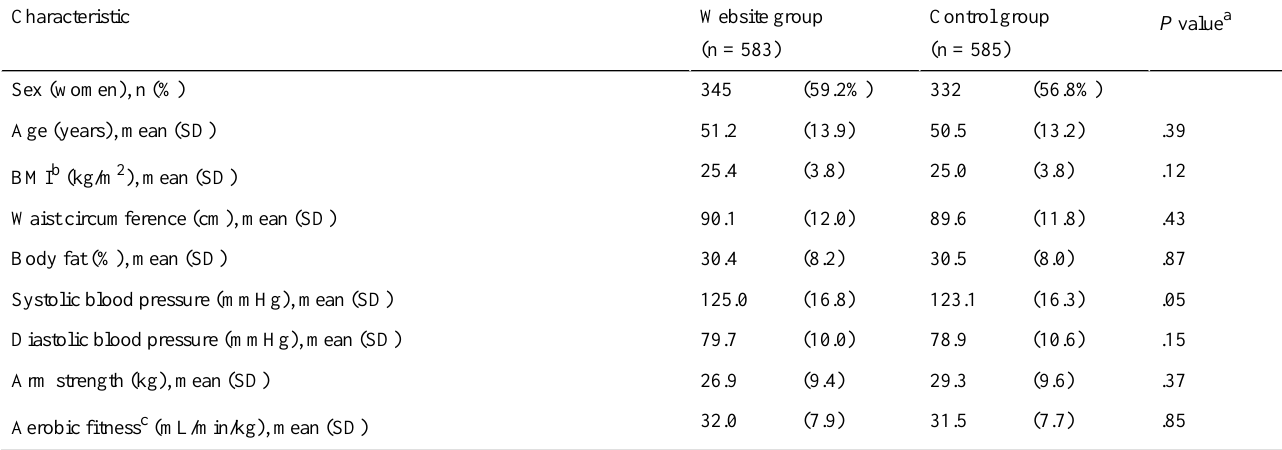
Table 3. Baseline characteristics of the subsample of participants in the health examination by website and control group (Denmark,